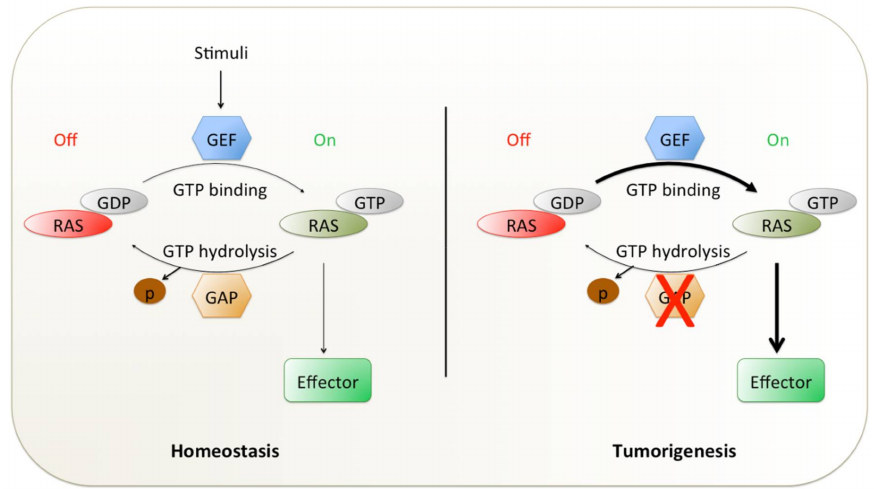
Figure 1. The two states of RAS family GTPases. GTP- and GDP-bound states are directed by GEFs and GAPs. GEFs stimulate the exchange of GDP to GTP, promoting activation of RAS (On). GAPs drive GTP hydrolysis and return to inactive GDP-bound status (O ff ). The thickness of the arrows indicates the strength of GTP binding as well as the (hyper)activation of downstream e ff ectors. The red cross indicates the impairment of GTP hydrolysis. GEF: guanine nucleotide exchange factor; GAP: GTPase-activating protein; GTP: guanosine triphosphate; GDP: guanosine diphosphate; RAS: rat sarcoma